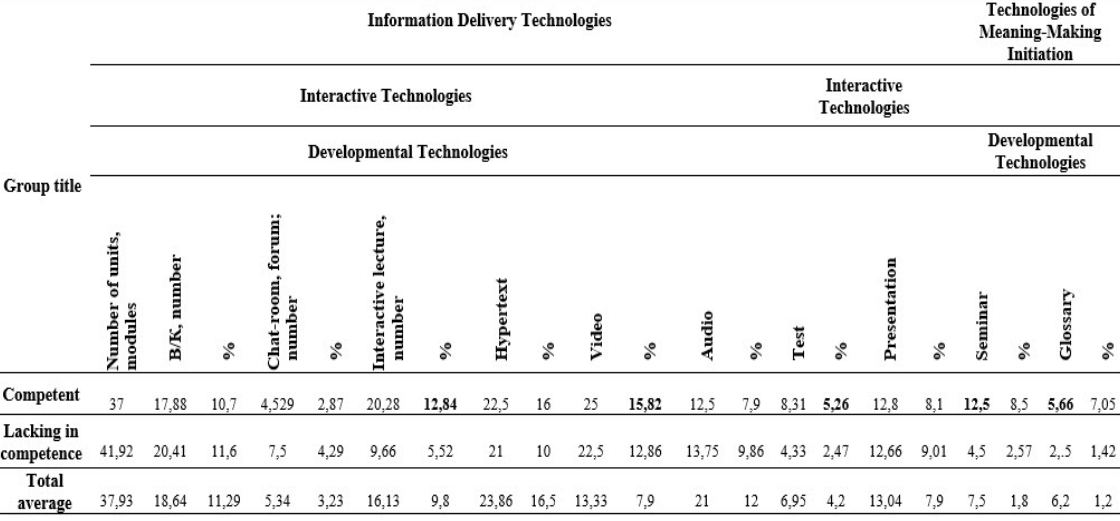
Table 3. Analysis of the way educational technologies are represented in the courses de- signed by distance learning